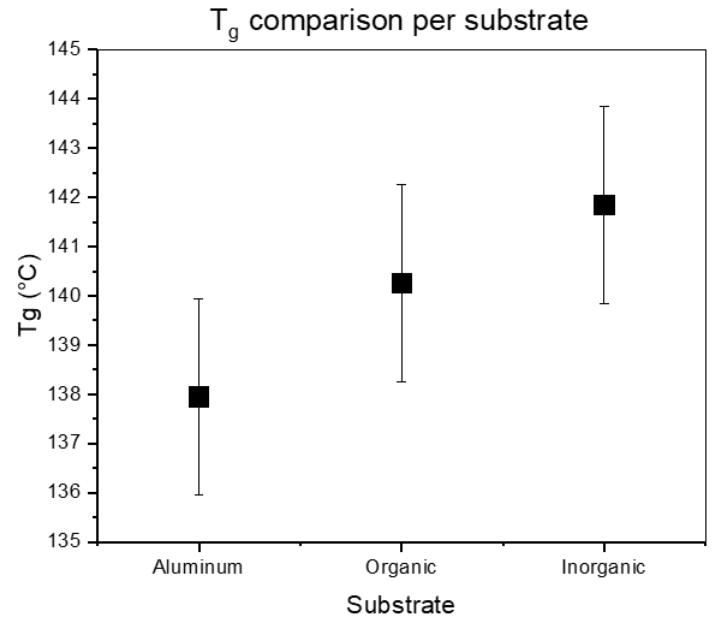
Figure 7. Comparison of T g values on the different underlayers. Table 2. DRS (30 nm thin film) measurement results for T g for different underlayers.